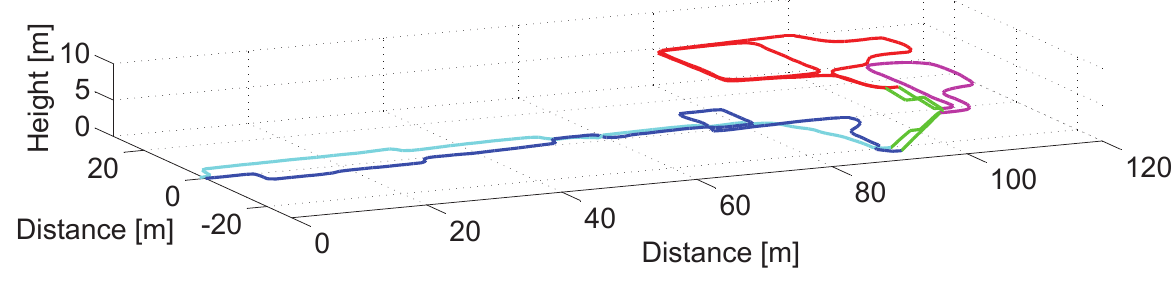
3D view of the odometry estimation of a 10-min’s walk at the Deutsches Museum, Munich